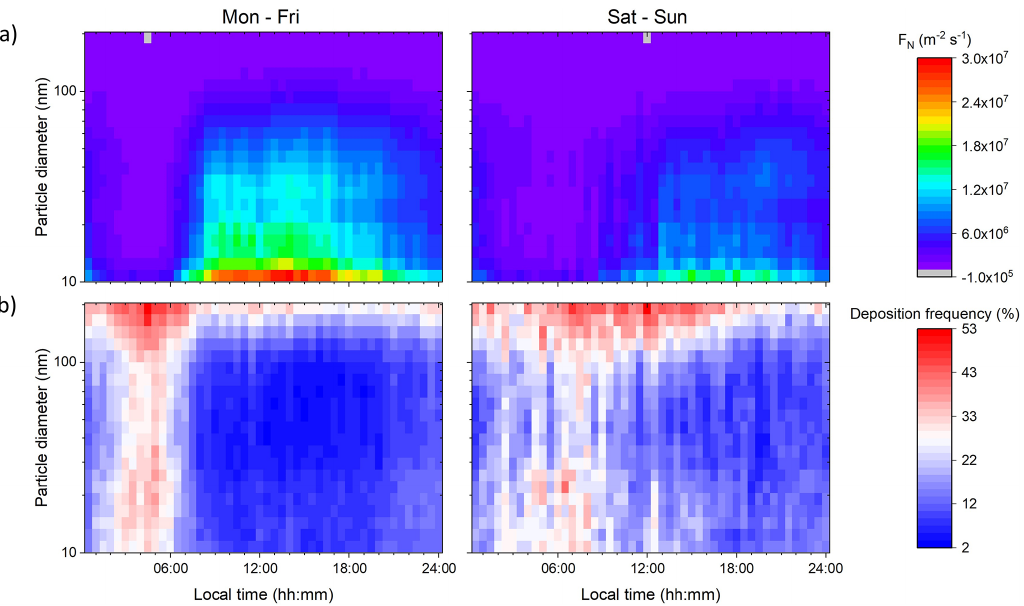
Figure 9. Diurnal cycles for a weekday (Monday–Friday) and a day during the weekend (Saturday–Sunday) of (a) size-resolved average particle number fluxes ( F N ) and (b) the frequency of particle deposition. In panel (a) colours indicate the strength of emission fluxes, while the grey colour symbolizes a slight particle deposition.